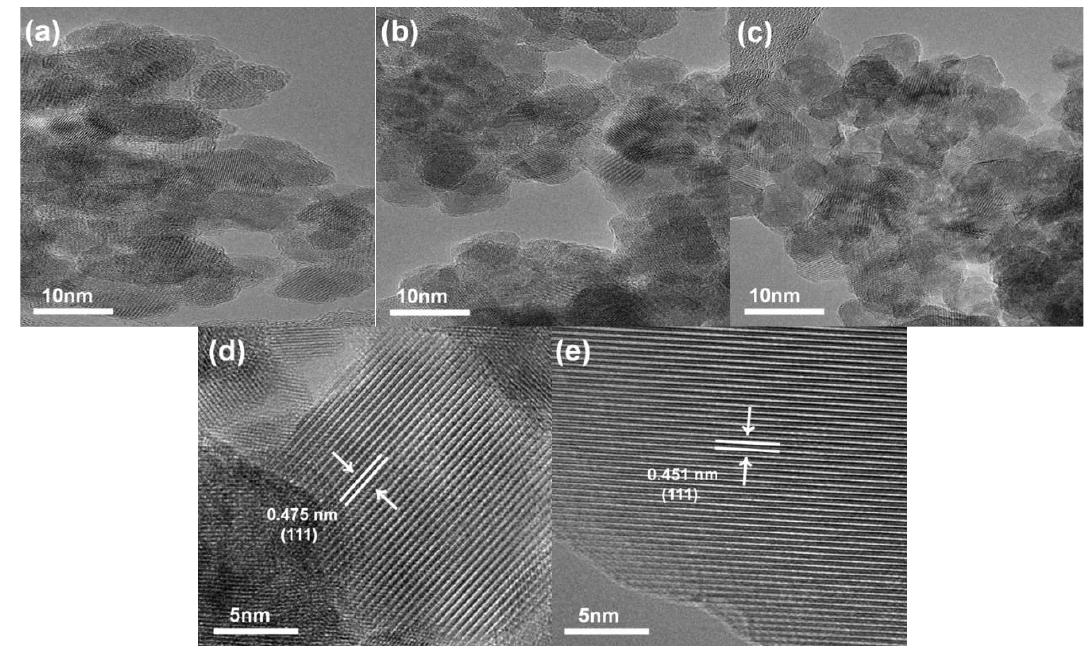
Figure 3. HR-TEM images of ( a ) CFO ( b , d ) CO-CFO-12.5 and ( c , e ) CO.